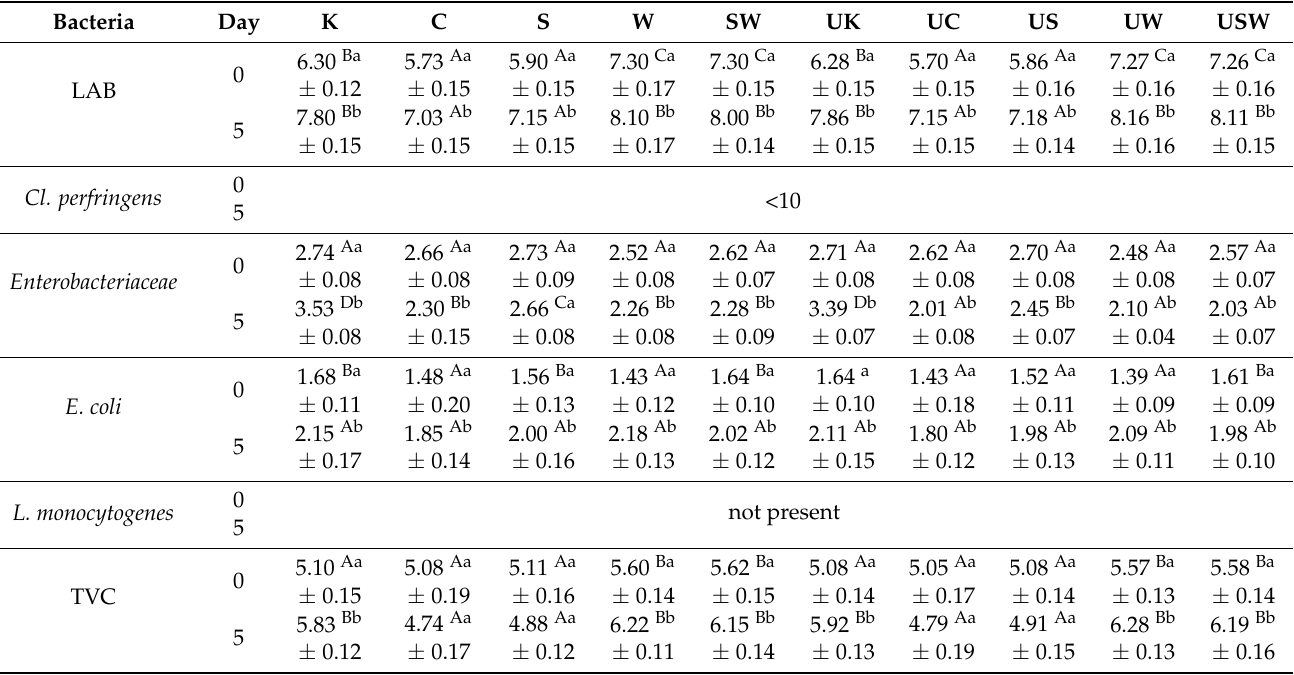
Table 5. Microbialcounts(logCFUg − 1 )oflambstuffingbeforeandafter5-daystorage(mean ±